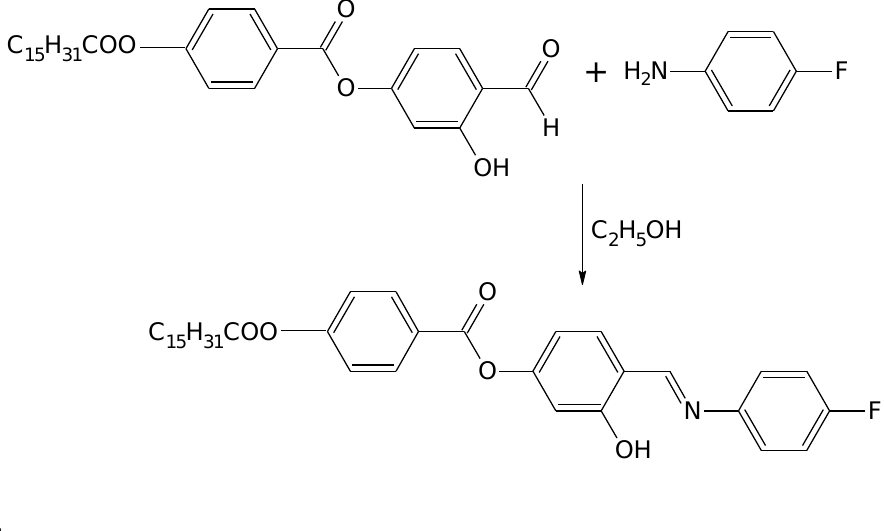
Experimental Analytical data were obtained on Perkin Elmer 2400 LS series CHNS/O analyzers. Electron impact mass spectra (EI-MS) were recorded by Hewlett Packard 5989A Mass Spectrometer operating at 70 eV ionizing energy. FT-IR data were recorded on a Perkin Elmer 2000-FTIR spectrophotometer. NMR spectra were recorded in CDCl on a Bruker 400 MHz Ultrashield Spectrometer. 3 4-(4- n -Hexadecanoyloxybenzoyloxy)-2-hydroxybenzaldehye was prepared according to method described in our previous work [9]. In a round-bottom flask, a mixture of the aldehyde (2.48